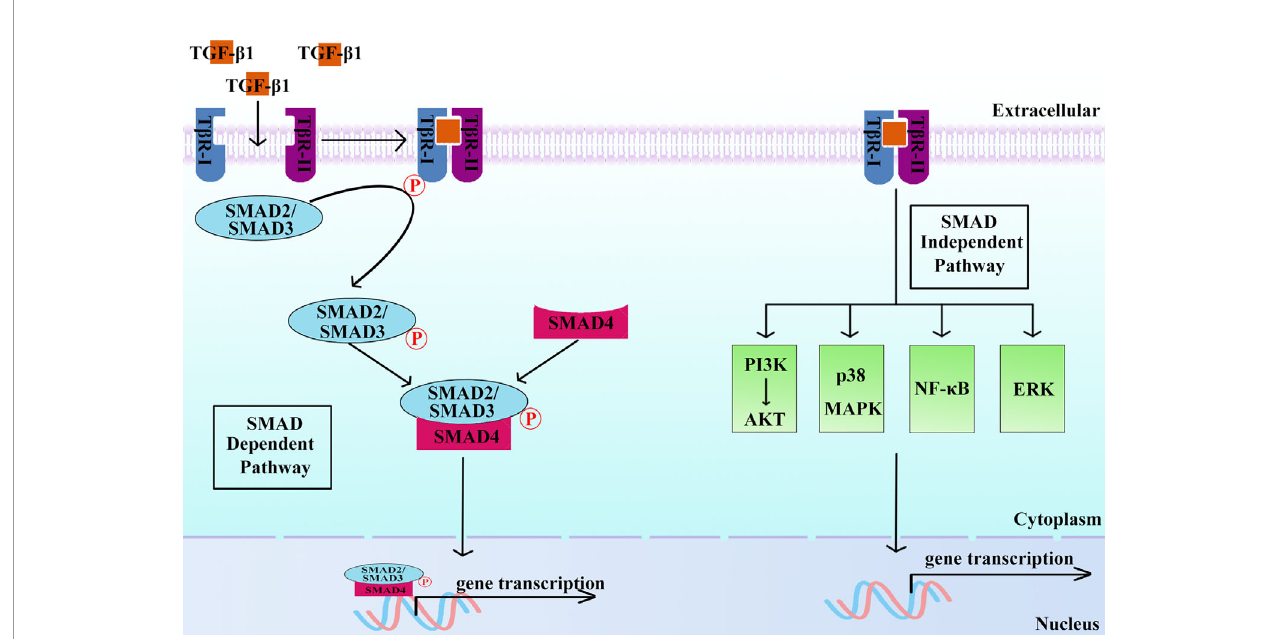
FIGURE 1 | Active TGF- b 1 functions via SMAD-dependent and/or SMAD-independent pathways. SMAD-dependent pathway: After TGF- b 1 binds to speci fi c receptors on the cell surface, phosphorylated T b R-I recruits and phosphorylates SMAD2 and SMAD3. Phosphorylated SMAD2 and/or SMAD3 combine with SMAD4 to form a trimeric complex, which can regulate gene expression in the nucleus. SMAD-independent pathway: After TGF- b 1 binds to receptors, phosphorylated T b R-I recruits and phosphorylates signaling molecules, such as PI3K-AKT, p38 MAPK, NF- k B, and ERK, and participates in the regulation of gene